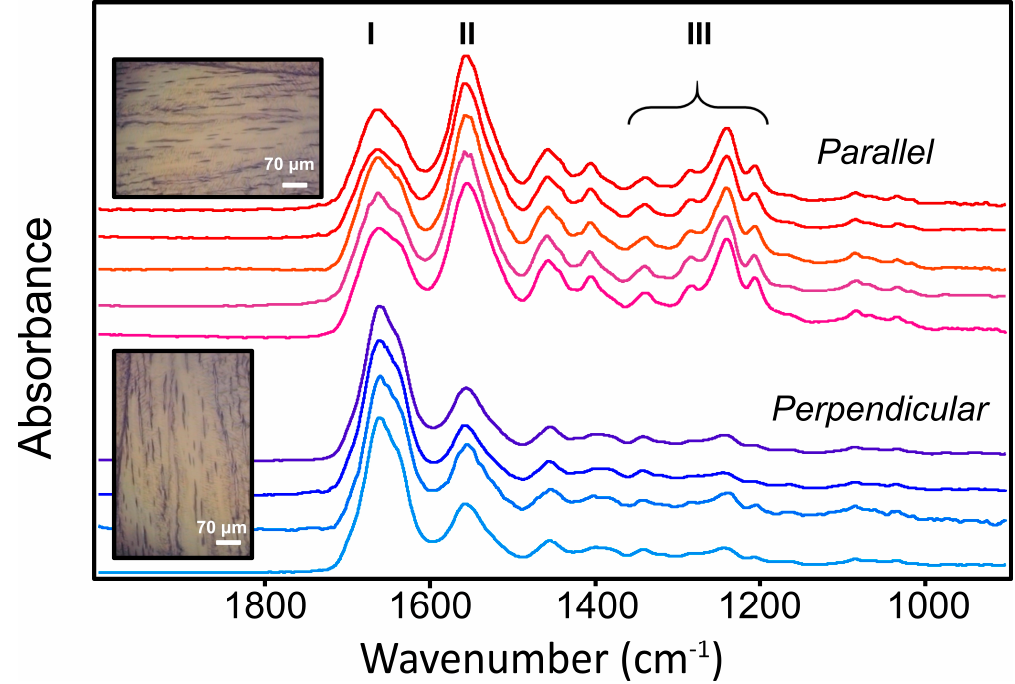
Figure 1. Far-field Fourier transform IR (FF-FTIR) spectra of intact tendon on BaF 2 from mosaic images obtained with focal plane array (FPA) detection, labelled to show Amide I, II and III regions. Each spectrum is derived from a different mosaic and is an average of about 20 spectra selected from the most oriented region in the field of view. Visible images show typical appearance of straightened tendon, imaged with same polarizer setting (90°) aligned with or rotated to be perpendicular to the polarizer. Scale bar = 70 μ m.